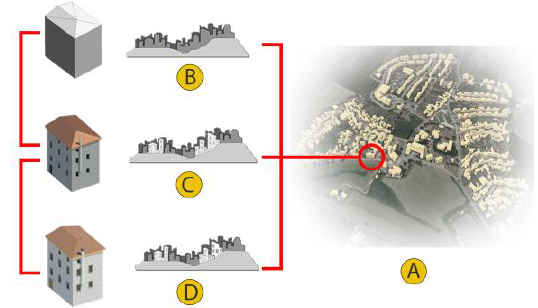
Figure 6. Definition of the multiscale workflow developed inside the HBIM information model of “La Martella”.